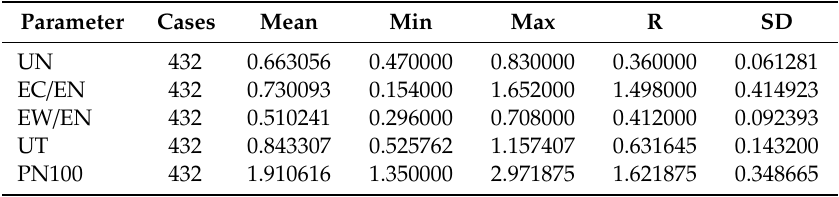
Table 2. The mean, minimum, maximum, range, and standard deviation values for illuminance uniformity UN, EC / EN, EW / EN, UT, and